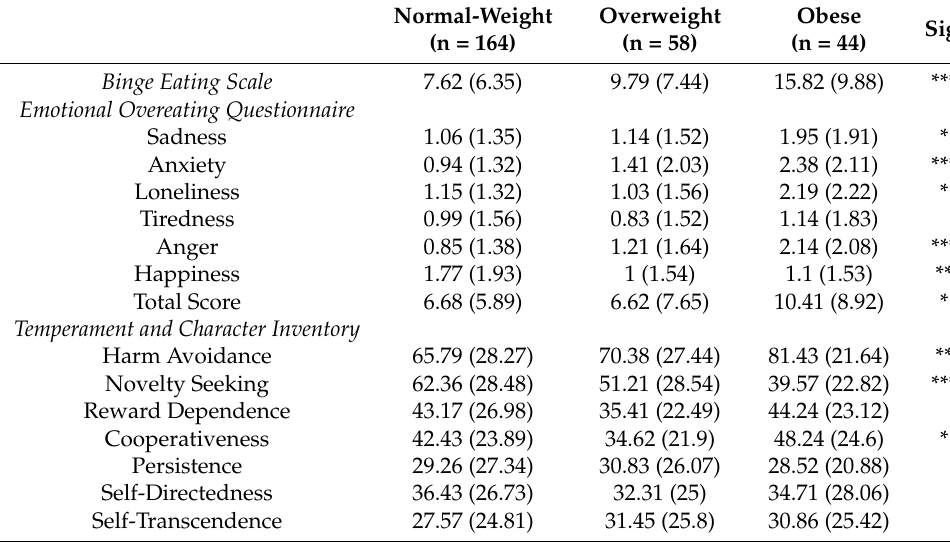
Table 2. Mean scores (SDs) for each